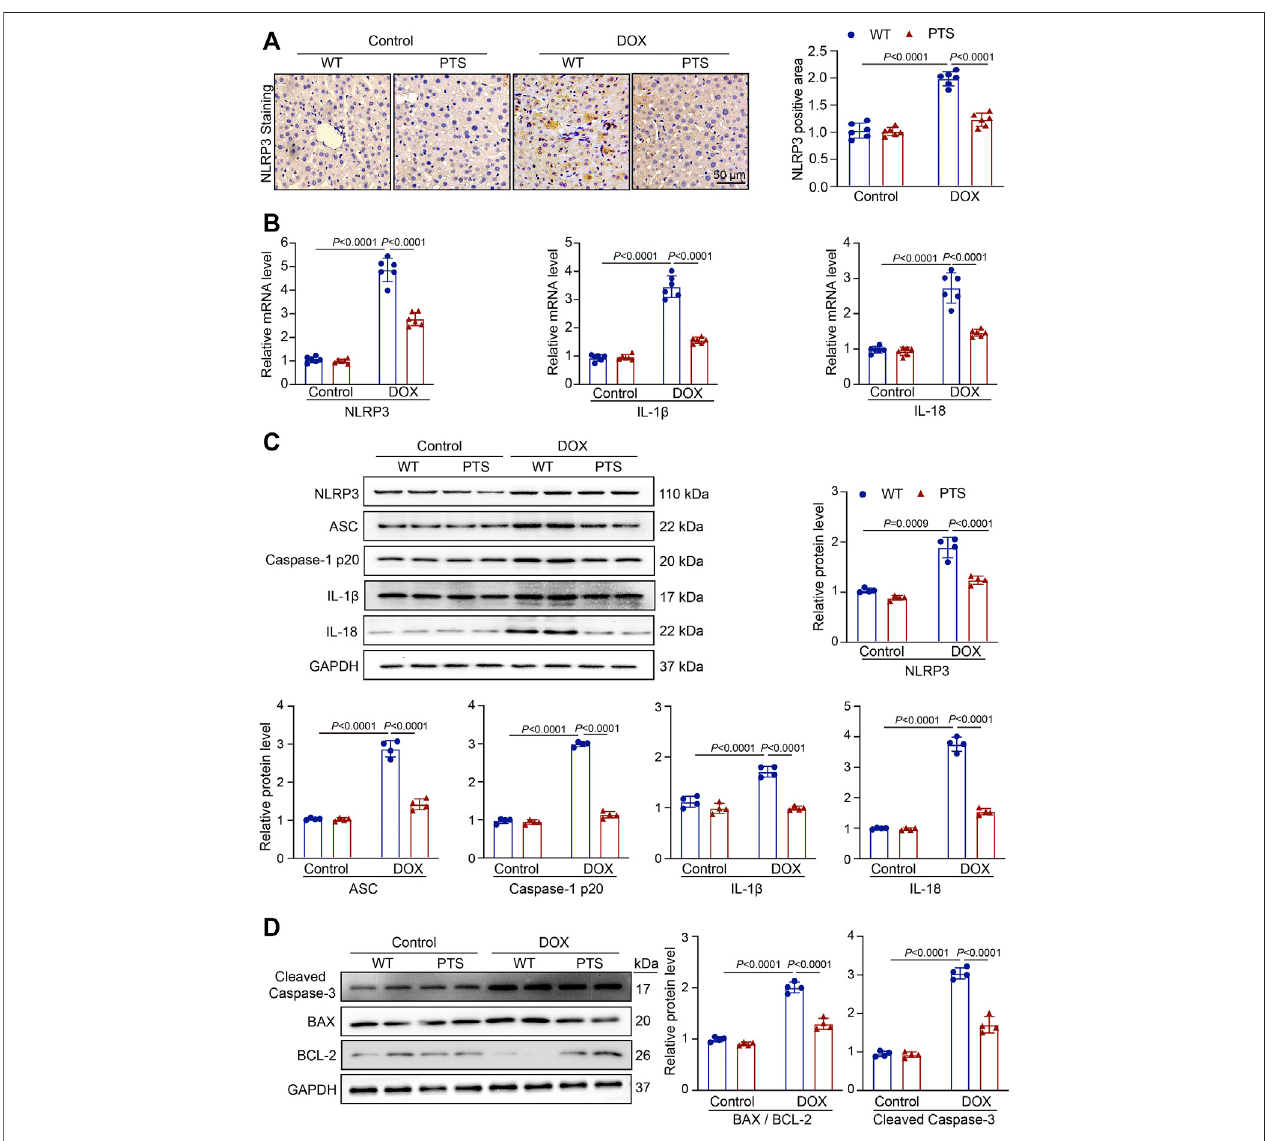
FIGURE 2 | PTS reduces reduction of NLRP3 in fl ammasome and apoptosis in DOX-treated mice. (A) WT C57/BL6J mice were pretreated with PTS (10 mg/kg) and afterwards with DOX (20 mg/kg cumulative dose) for 6 days. Immunochemistry staining of the liver sections with anti-NLRP3 (left, scale bar = 50 μ m), the quanti fi cation of NLRP3 positive area in each group (right, n = 6); (B) qPCR analyses of NLRP3, IL-1 β and IL-18 mRNA levels in each group ( n = 6); (C) Western blot analysesofNLRP3,ASC,Caspase-1p20,IL-1 β ,and IL-18proteinsandthequanti fi cationoftheblotsineach group( n =4pergroup); (D) Westernblotanalysesof Cleaved Caspase-3, BAX, and BCL-2 proteins (left) and quanti fi cation of the blots in each group (right, n = 4 per group).